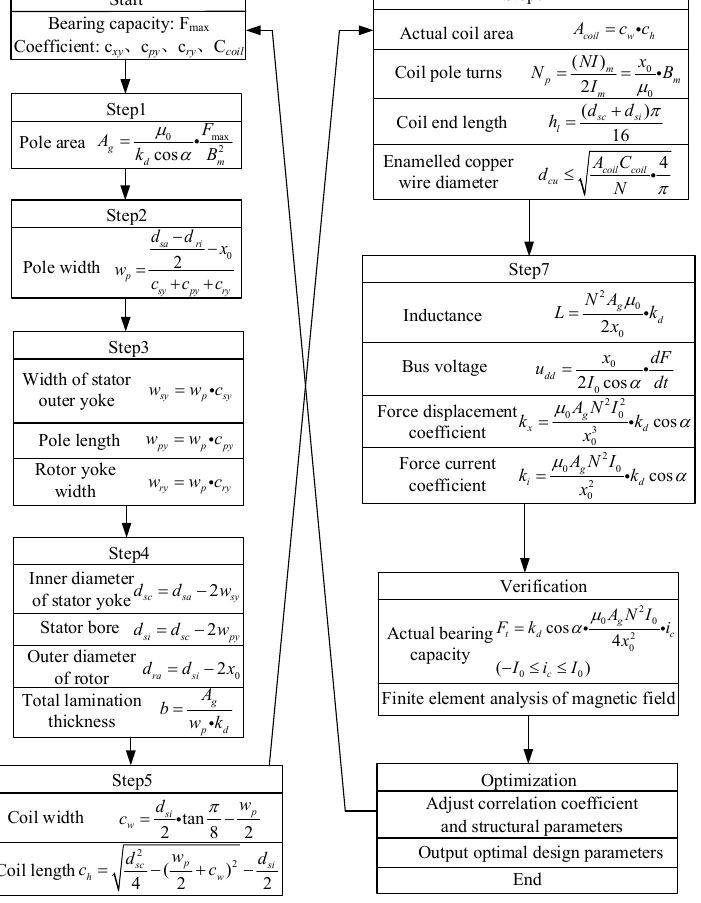
Table 1. Structural parameters of the 8 ‐ pole RMB.